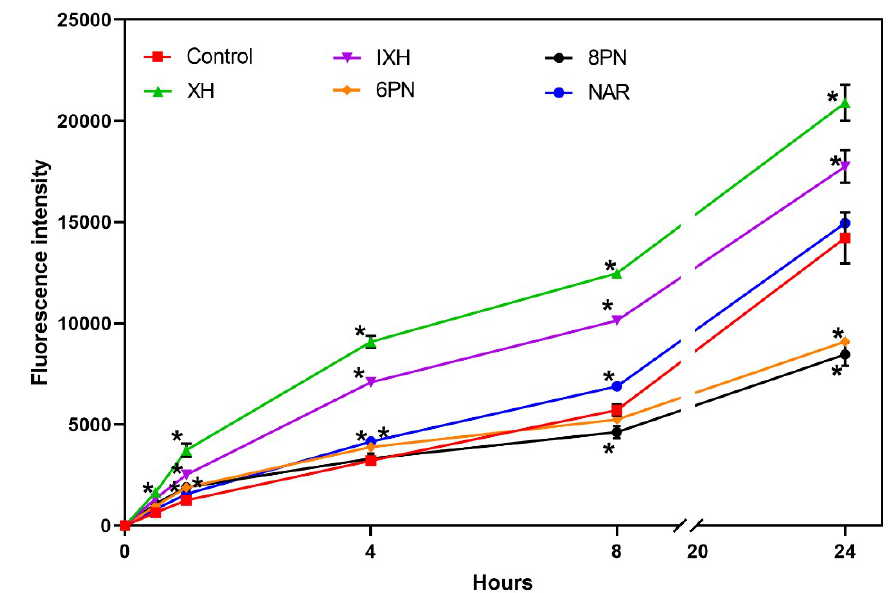
Figure 3. Effect of prenylflavonoids and naringenin on the ROS formation in SW620 cells. Data represent the mean ± S.D. ( n = 3) (* data with p < 0.001, one-way ANOVA with Dunett’s test).